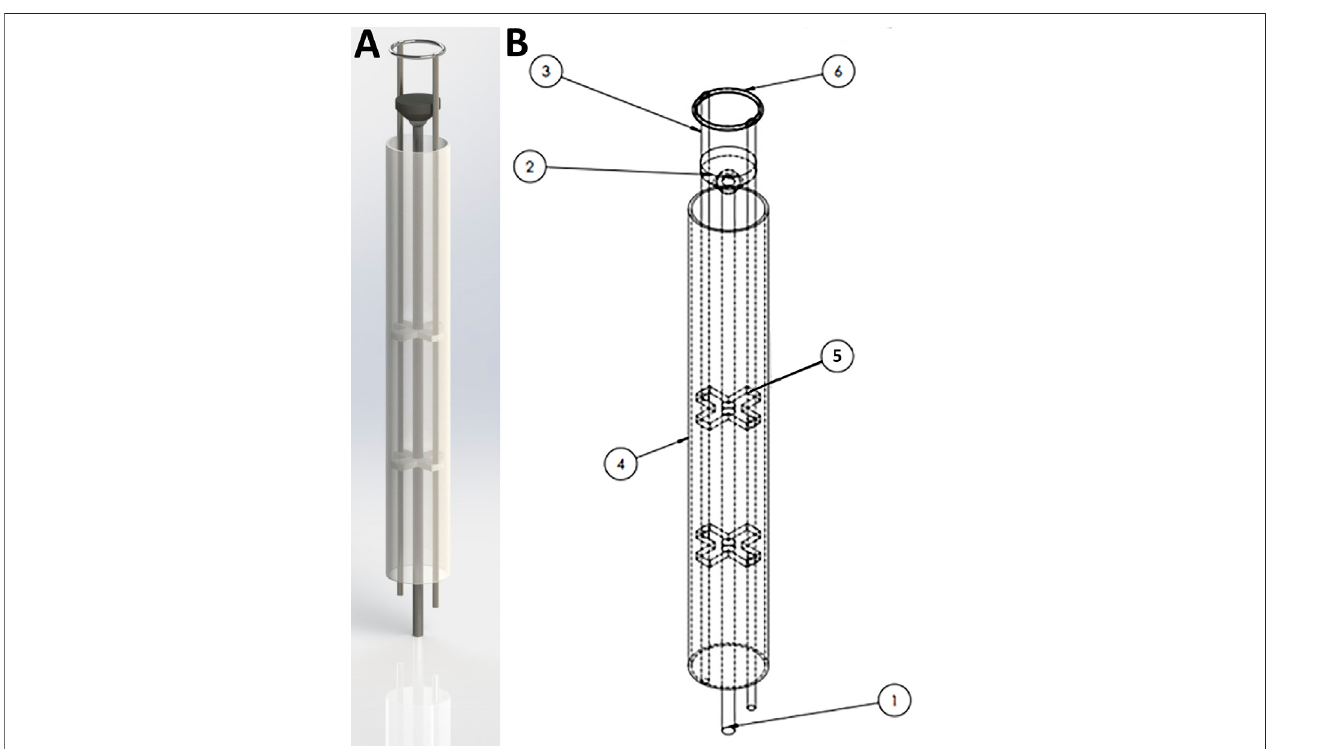
FIGURE 5 | SolidWorks design for the HeartStamp device prototype. 3D rendering of the HeartStamp instrument (A) and technical details with labelled parts (B) . Item labels: 1) Central Rod (controls the puck); 2) Puck (pushes patch off the ring and onto the heart); 3) Paired Ring Rod (controls the ring angle); 4) Tube (provides protectionforcomponents-tube lengthismodi fi ablewithalongtube shownherewhereasashorttubeversion wasusedatsurgeryandshownin Figure4 );5)PairedX- shaped Support (supports the rods); 6) Metal ring (the heart patch is rested on this). The resulting prototype generated from these computer-aided designs is shown in Figure 4 and the raw data are available in the Supplementary Materials .